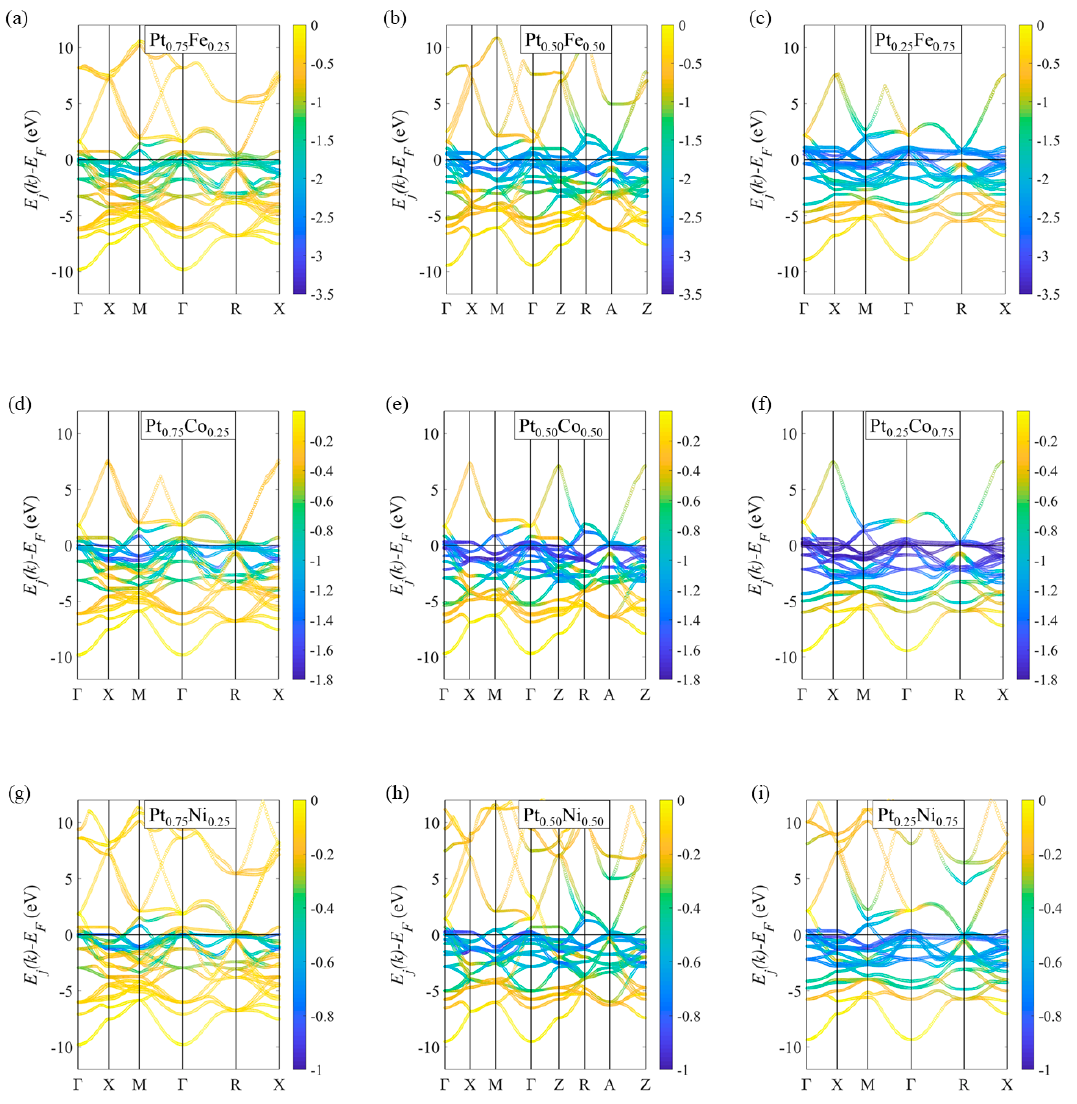
Figure 2. Spin-resolved electronic band structures of the ( a – c ) Pt x Fe 1 − x , ( d – f ) Pt x Co 1 − x and ( g – i ) Pt x Ni 1 − x ordered alloys. The Pt 0.50 Fe 0.50 , Pt 0.50 Co 0.50 and Pt 0.50 Ni 0.50 alloys are ordered L1 2 structures, whereas the remaining alloys are L1 0 . E F is the Fermi level, and the legends show the exchange splitting δ ε ex;j in eV.